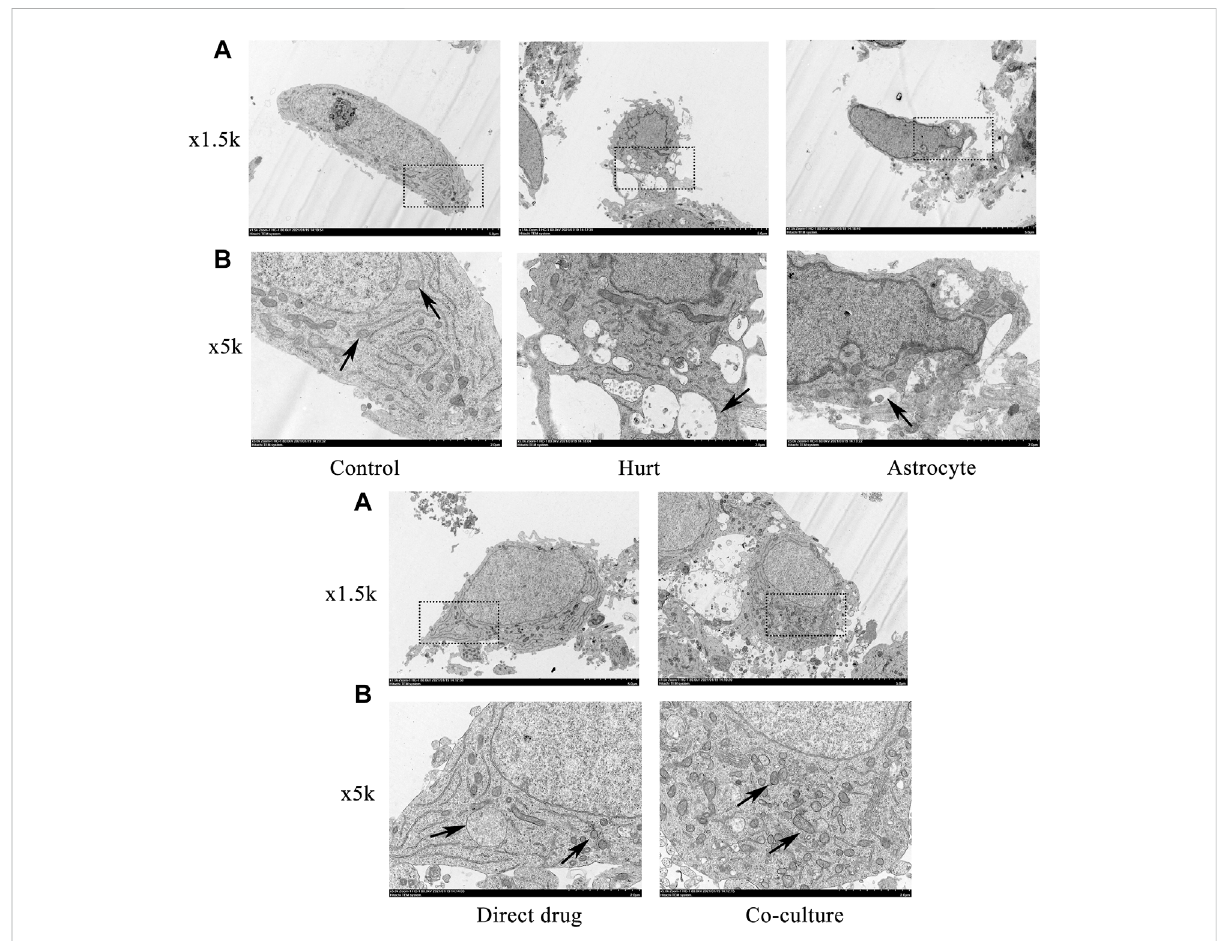
FIGURE 9 TFHLfacilitates microstructure and autophagosome change of injuredSMNs. Observation of microstructure and autophagosome change in SMNs of eachgroupbytransmissionelectronmicroscopy. (A) Under×1.5 kelectronmicroscope,themicrostructureinSMNsofeachgroupwasobserved,withscale bars = 5 μ M. (B) Under a ×5 k electron microscope, the autophagosomes in SMNs were observed, with scale bars = 2 μ M. The black dashed box is the observation site under the ×5 k magni fi cation, the black arrow points to the autophagosome. SMNs: spinal motor